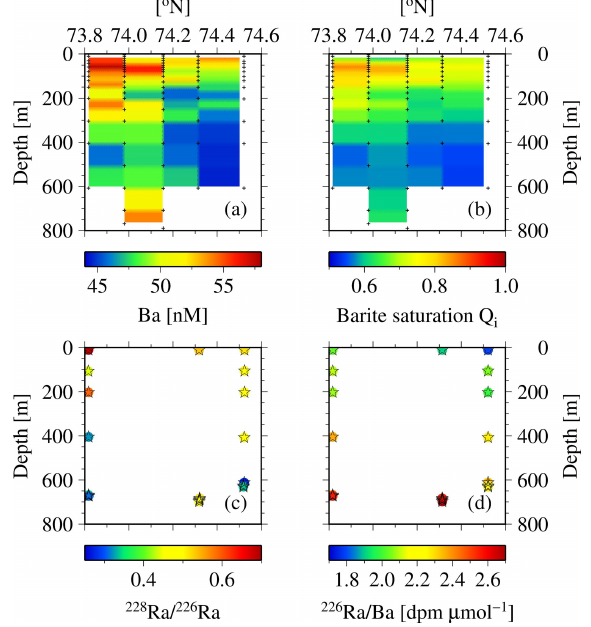
Figure 11. Cross section at stations CAA1–CAA3, 323, and 324 for (a) dissolved Ba and (b) barite saturation state ( Q i ) as well as (c) 228 Ra / 226 Ra and (d) 226 Ra / Ba (dpmµmol − 1 ). The low val- ues of both properties indicate the presence of Atlantic water (see Thomas et al.,